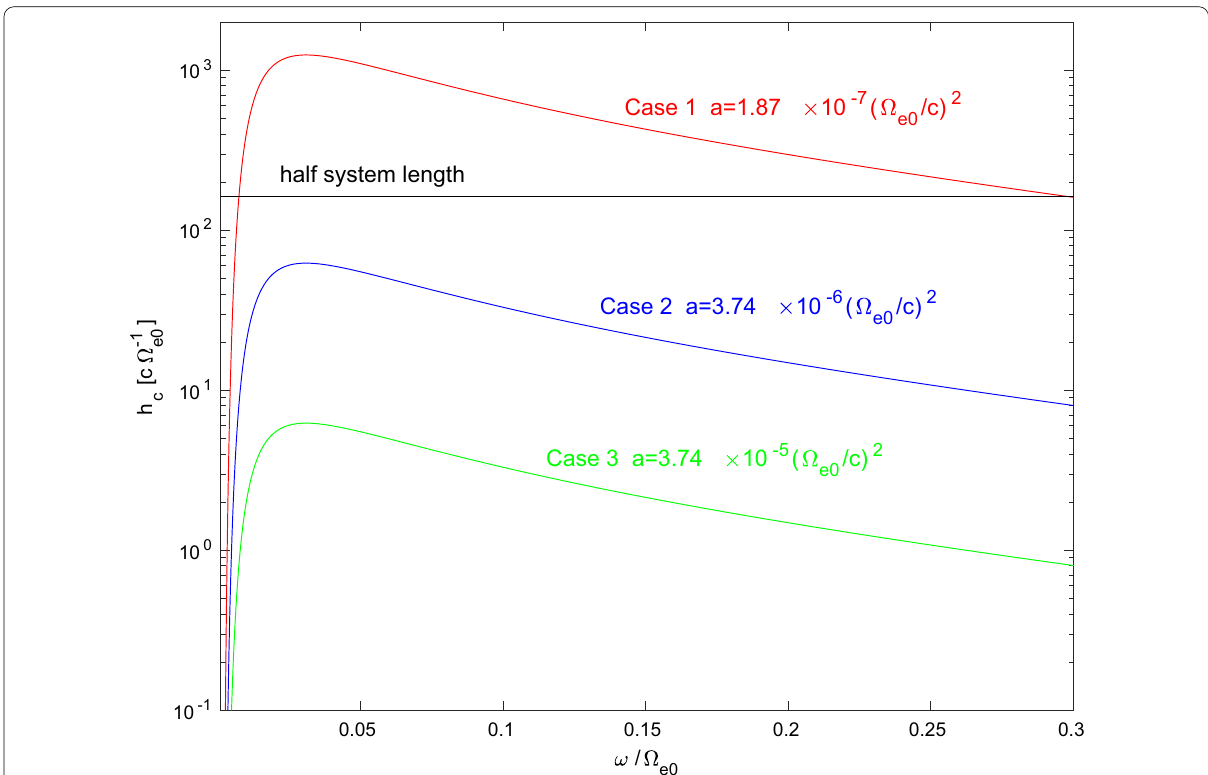
Fig. 4 Critical distances under different gradients of the background magnetic field and half of the system length with the same parameters assumed in Fig.